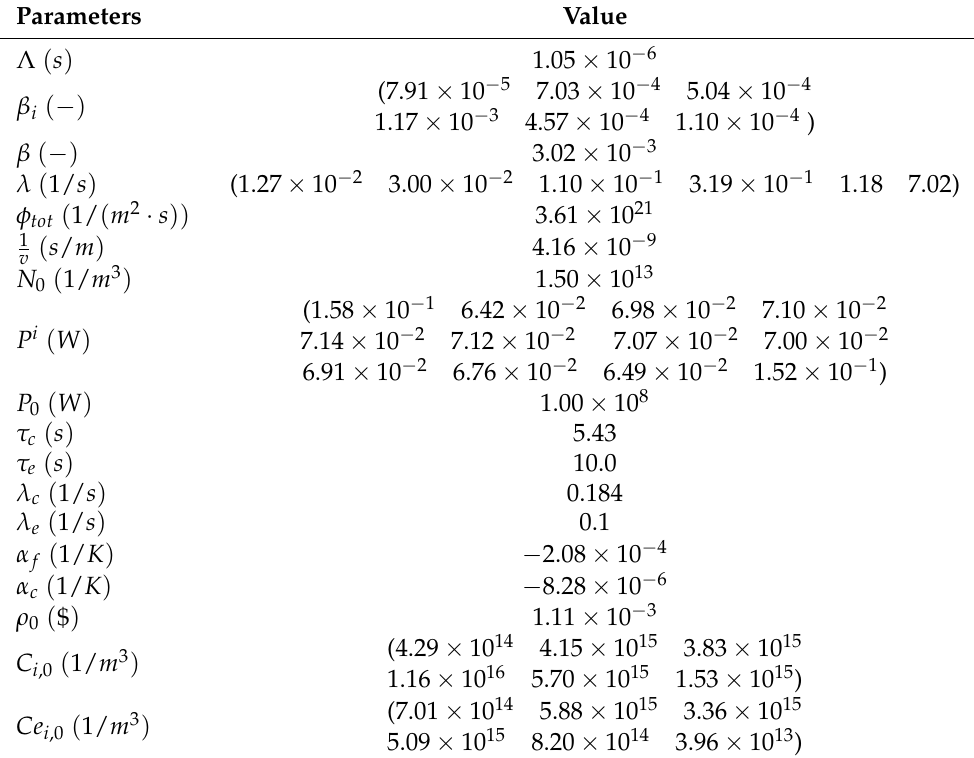
Table 2. Neutronics data for the point kinetic model.